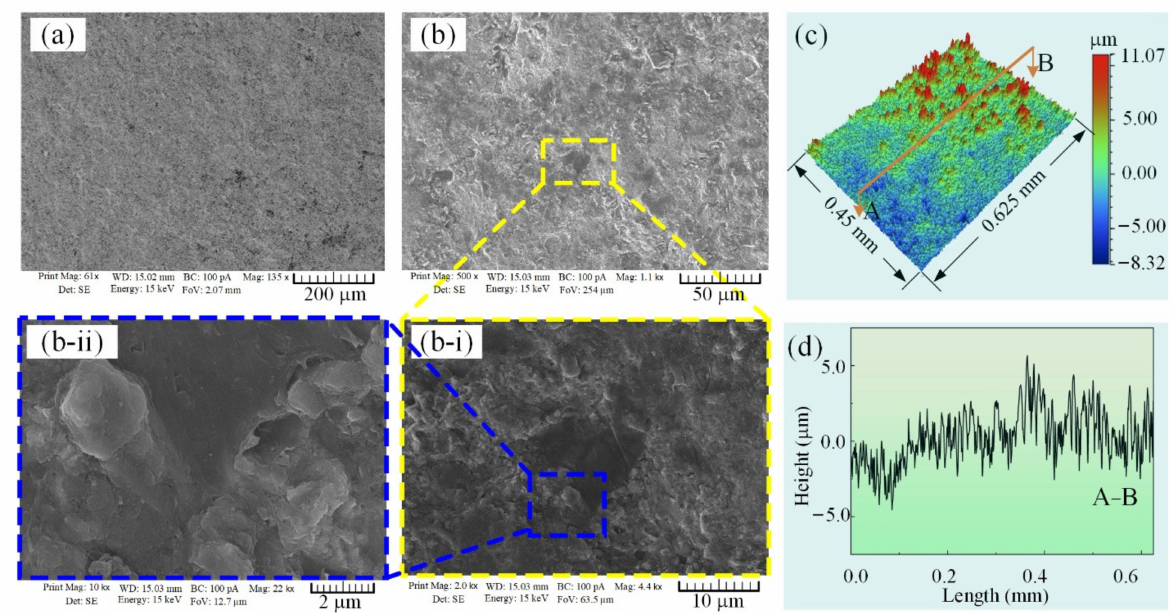
Figure 6. SEM micrographs and their enlarged appearances ( a , b ), 3D micrographs ( c ), and height profile images ( d ) of USGP sample. A-B means the cross section of micrographs through line AB.